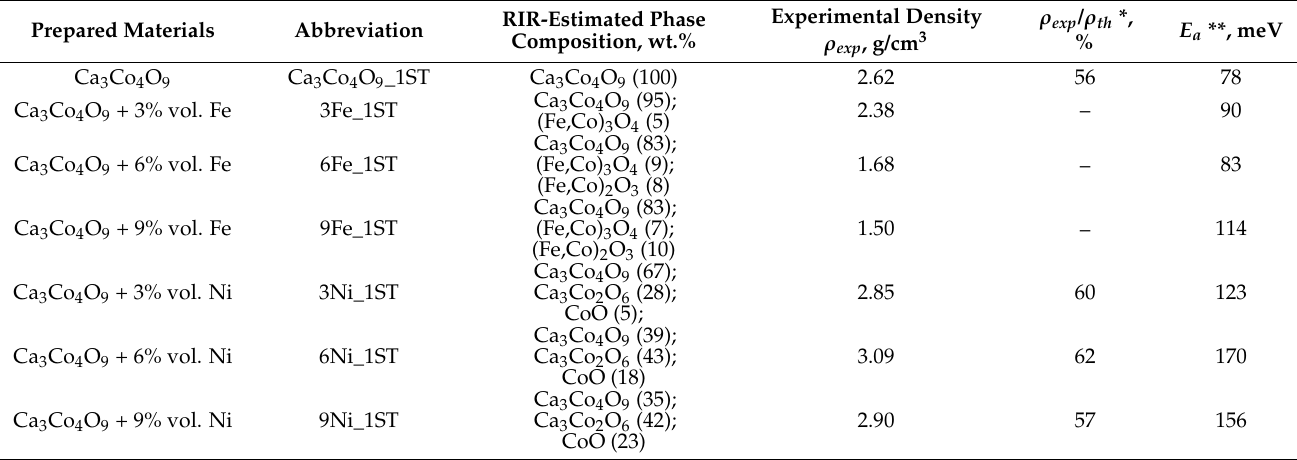
Table 1. Abbreviations, phase composition, relative densities, and activation energies for all one-stage (1ST) sintered